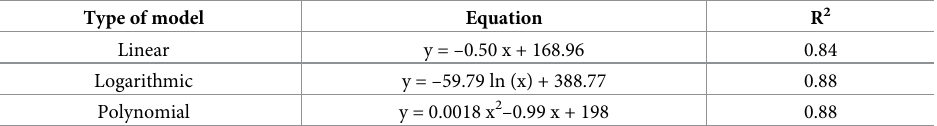
Table 2. Adjustment models with their respective R 2 for the fundamental frequency as a function of the standard length in red-bellied Pygocentrus nattereri .